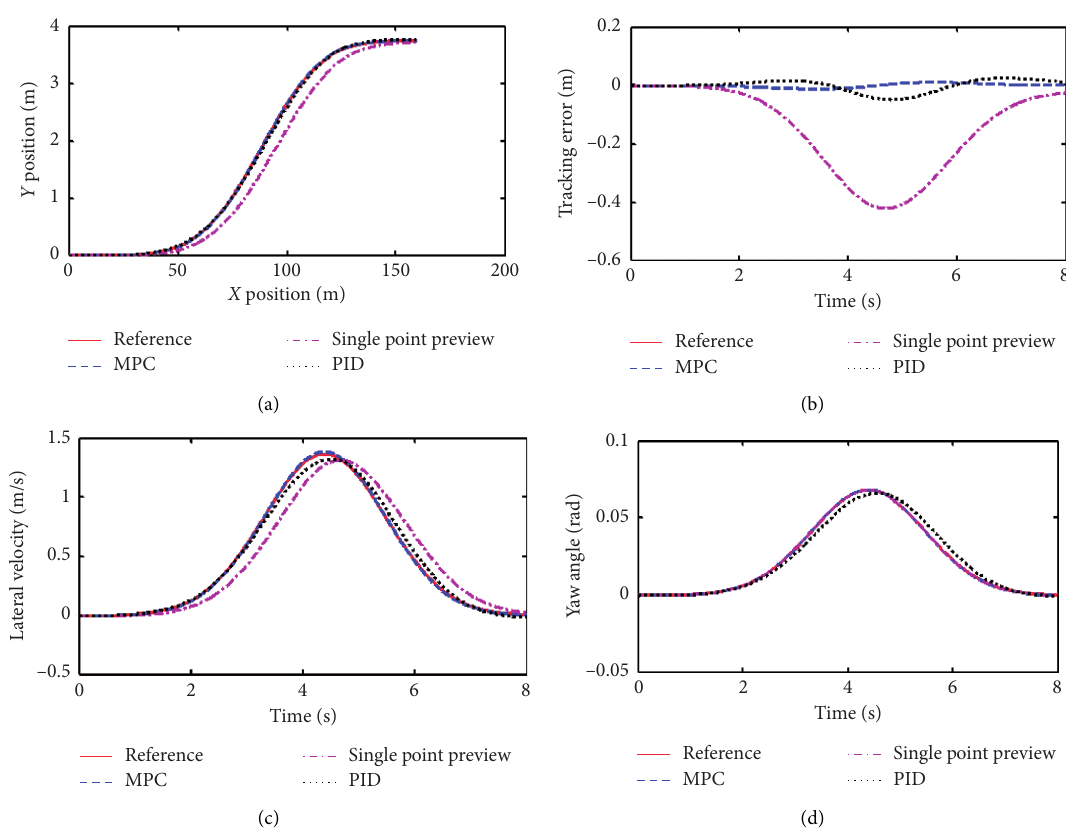
Figure 7: Model comparative study of controller. (a) Global path. (b) Tracking error. (c) Lateral velocity. (d) Yaw